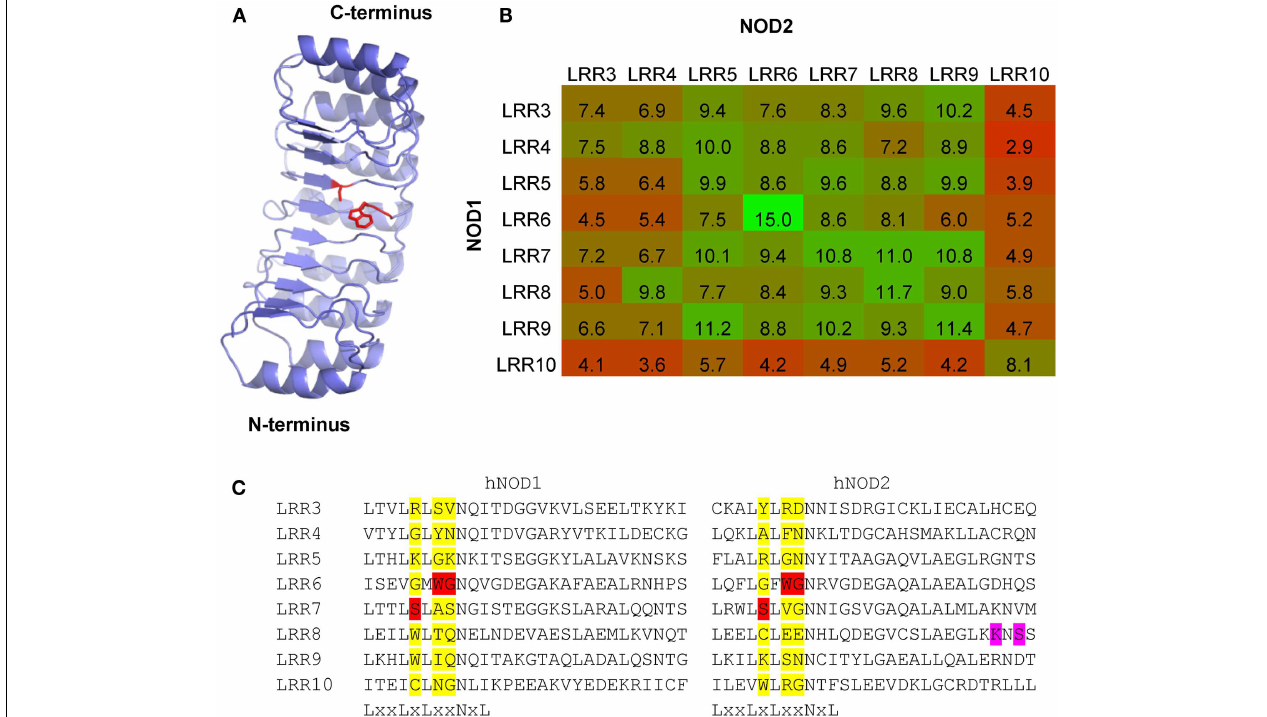
FIGURE 6 | Patterns of LRR conservation between NOD1 and NOD2 support a conserved ligand binding surface . (A) Other than the signature residues in the LxxLxLxxNxL motif only three residues –W820, G821, and S846 (NOD1);W907, G908, and S933 (NOD2) – are conserved across all examined species of NOD1 and all mammalian NOD2 sequences.The likely spatial position of these residues on the concave surface of NOD1 is shown.The residue sidechains are represented as red sticks. (B) Heat map representation of the relative similarity of the eight terminal LRR repeats in NOD1 and NOD2 from the human, chimpanzee, mouse, cow, elephant, platypus,